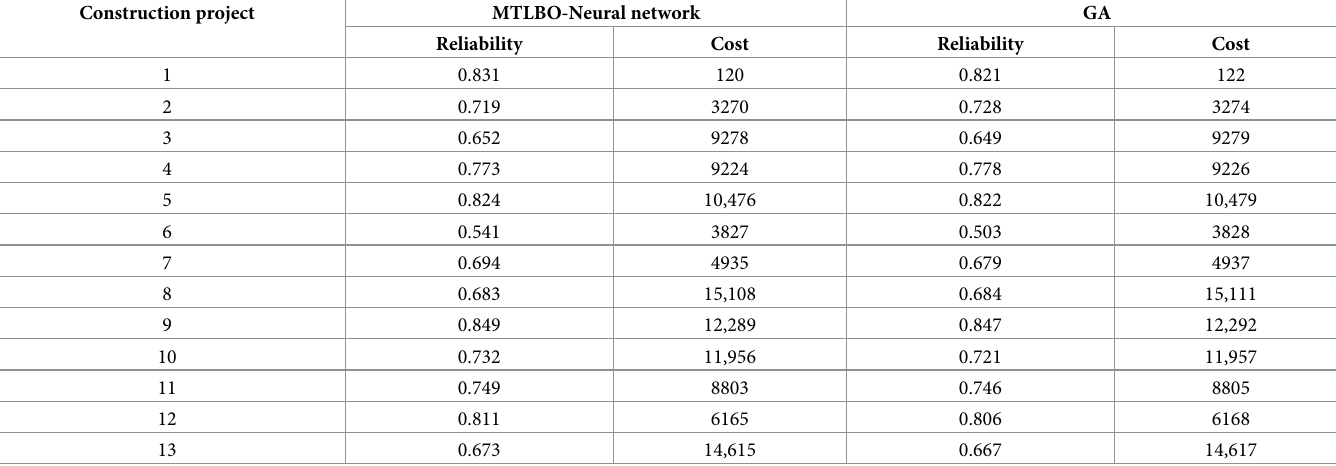
Table 5. Comparison of reliability optimization results of construction projects with two different algorithms. Construction